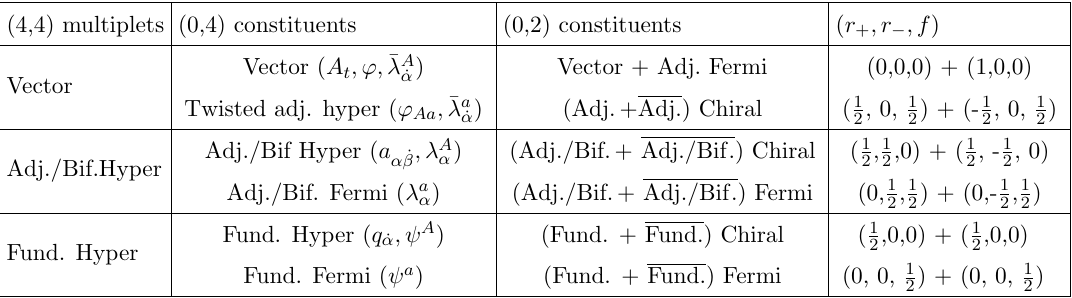
Table 1 . (4,4) mutiplets in terms of (0,4) and (0,2) multiplets. The last column lists the